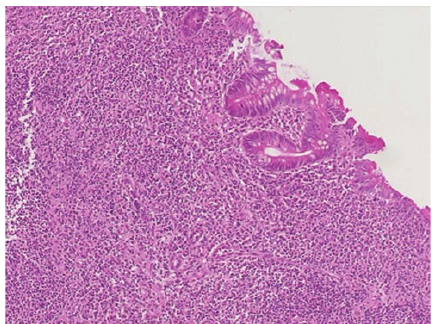
Figure 2: Ileal biopsy showed villus flattening with heavy infiltration of admixture of inflammatory cells rich in plasma